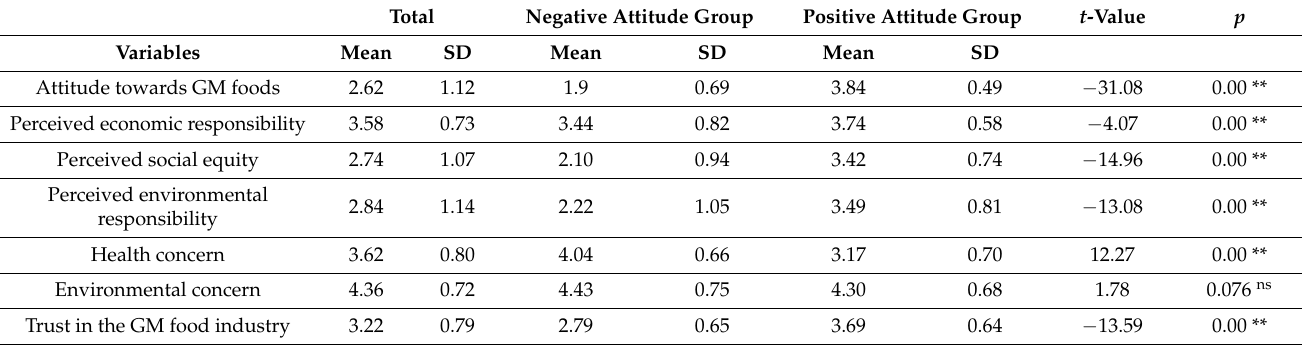
Table 3. Comparison of consumers with negative and positive attitudes towards GM food.